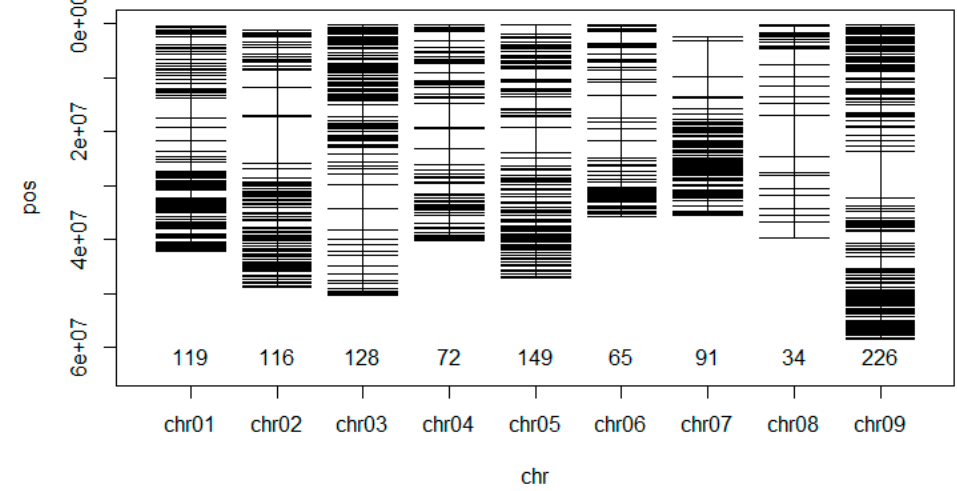
Figure 4. Genome ‐ wide distribution of the 1000 SNP markers selected for in ‐ depth genetic diversity and population structure analyses.